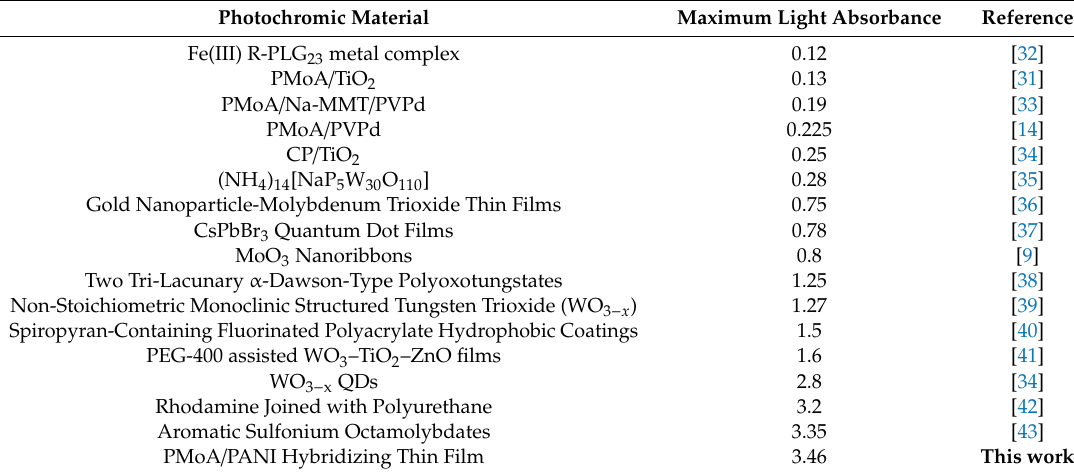
Table 2. Comparison of the maximum absorbance of photochromic